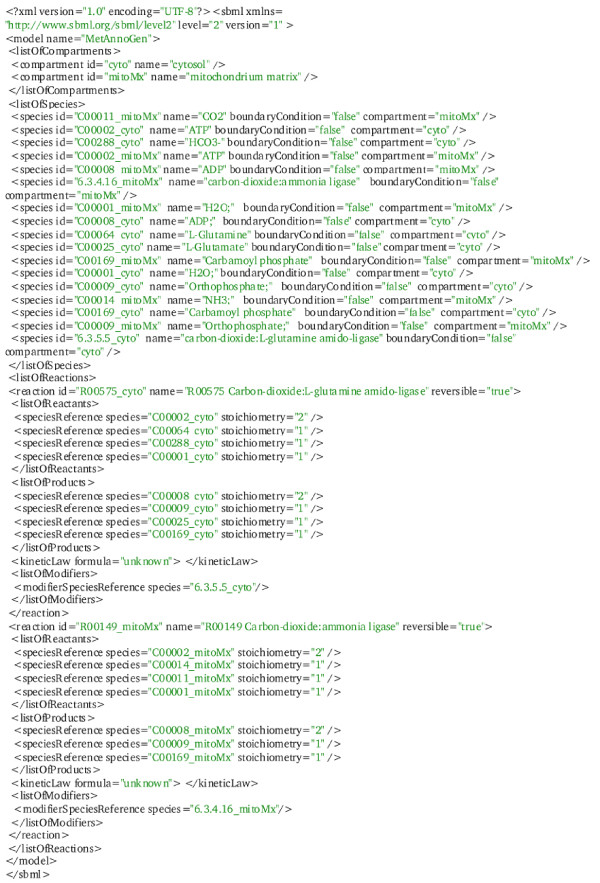
SBML-output containing the two enzymes described in section "Working with METANNOGEN – A case study". This file can be imported into modeling or simulation programs with SBML support.